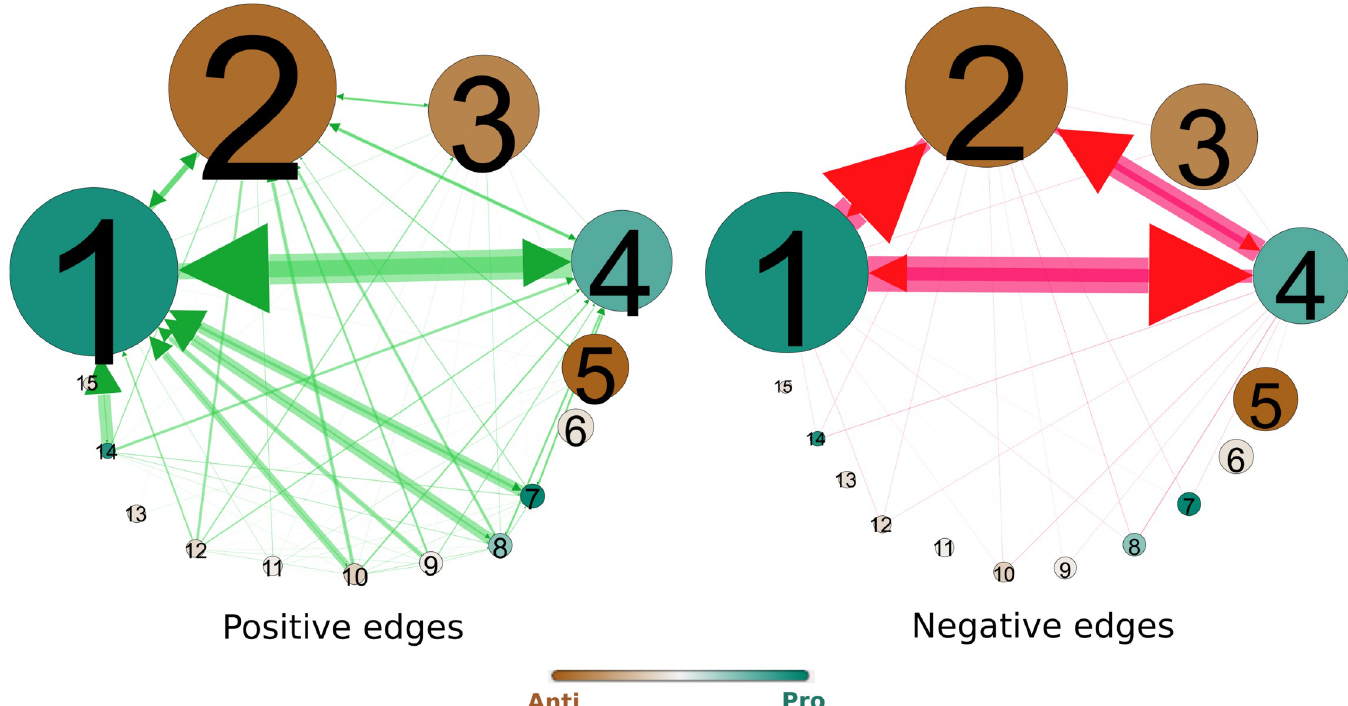
Fig 7. Community relations. The aggregate network of the communities, with positive relations (left) and negative relations (right). Nodes are sized by the number of users in this community and colored by the average issue sentiment of users in the community. Edges are sized by the absolute count of outgoing edges from source to target community, divided by the source community’s